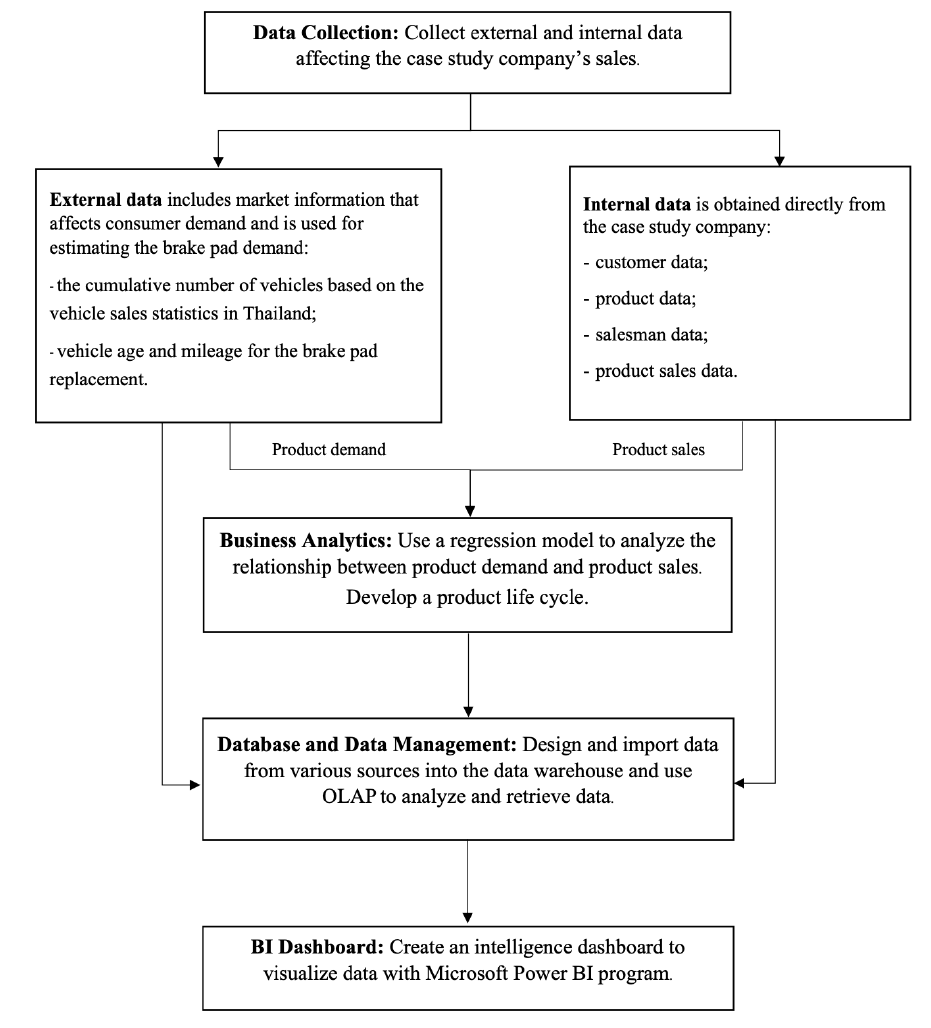
Figure 5. Research methodology flowchart.